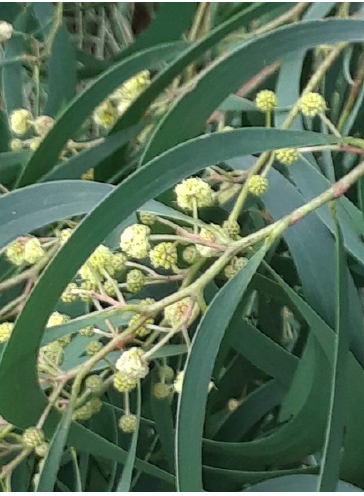
Figure A3. Koa flowering at 2 years.